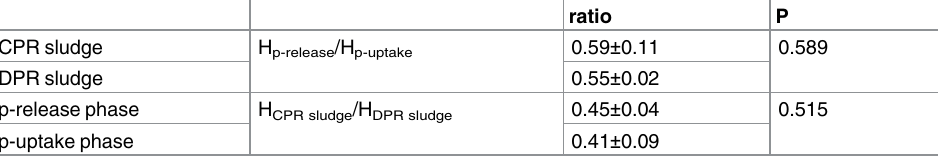
Table 2. Differencesin heat output between CPR and DPR sludges and between aerobic and anaero- bic phases.